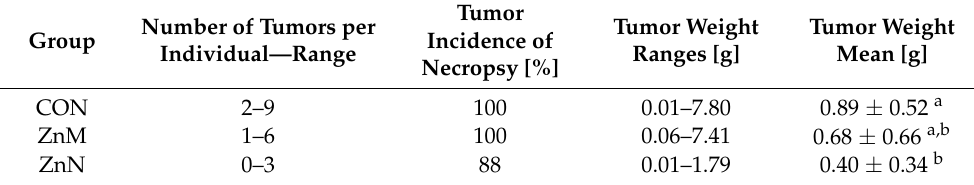
Table 3. The efficiency of tumor induction.